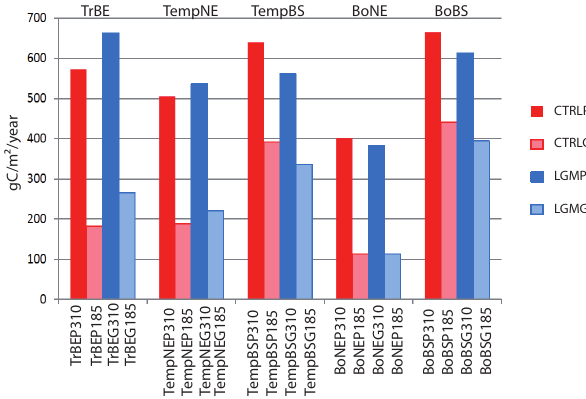
an imposed vegetation. Legend at the top: names of the PFTs (see Table 1). Legend to the right hand-side: climatic and CO 2 forcings (see Table 2). Legend at the bottom: names of the simulations (see Table